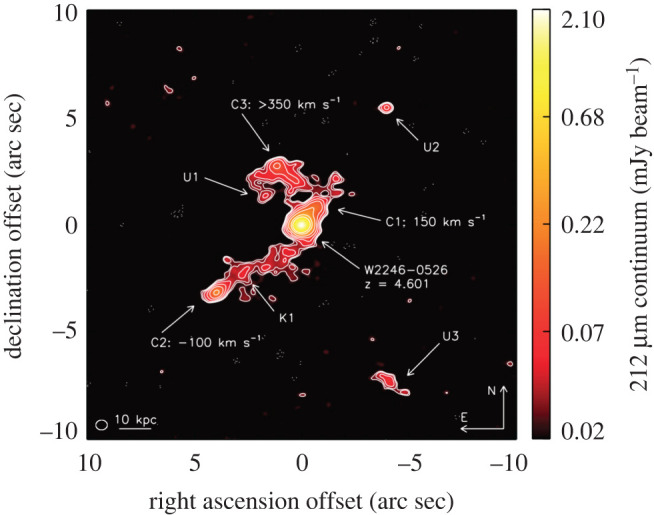
ALMA 212 μm dust continuum map (20″ × 20″) of the z = 4.6 merging system from Díaz-Santos et al. [505]. The labels indicate the three companion galaxies (C1, C2, C3) as well as a number of sources with unknown redshifts. The ALMA imaging reveals a stream of dusty material between W2246-0526 and C2 as well as bridges with C1 and C3, allowing an unprecedented view of this multiple merger event. Figure from Díaz-Santos et al. [505].